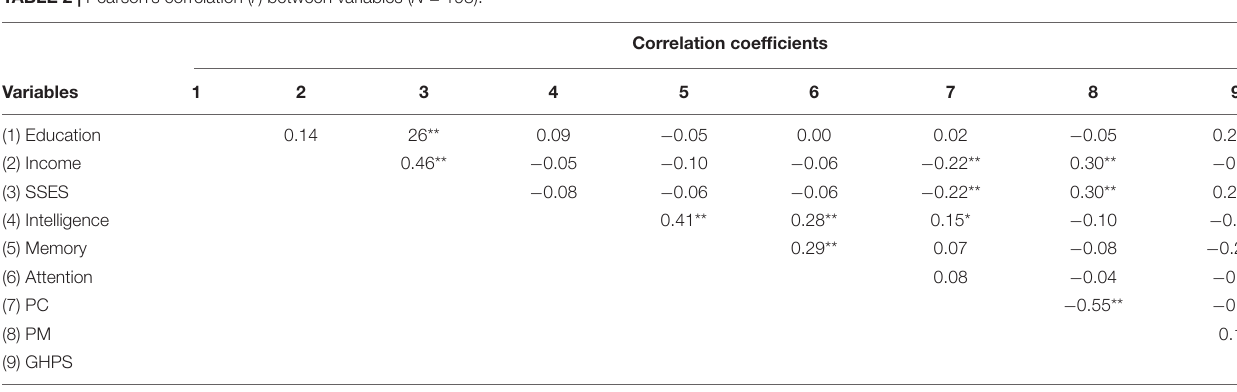
TABLE 2 | Pearson’s correlation ( r ) between variables ( N = 198).